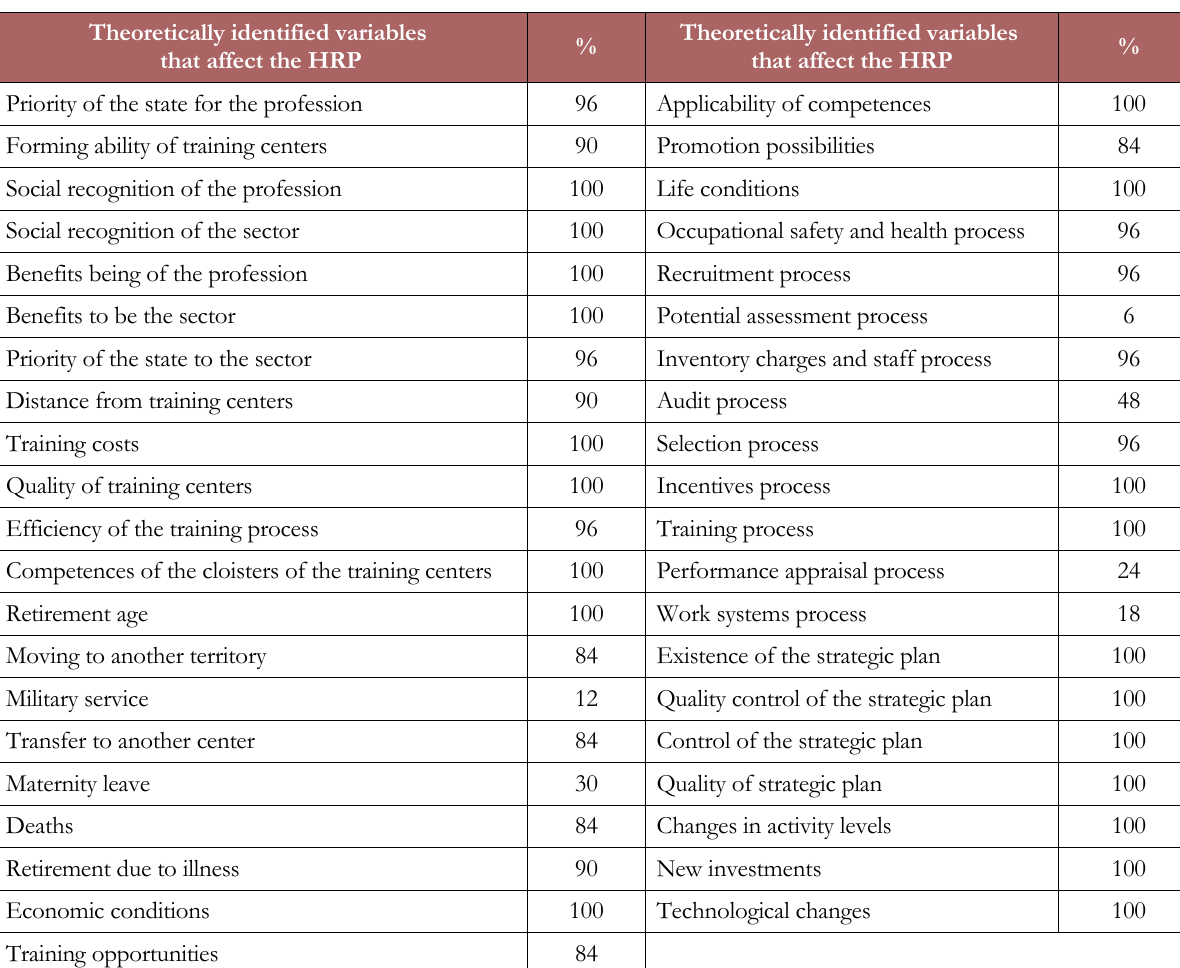
Table 1. Results of applying the experts applied for the ordering of the variables that affect the territorial level HRP